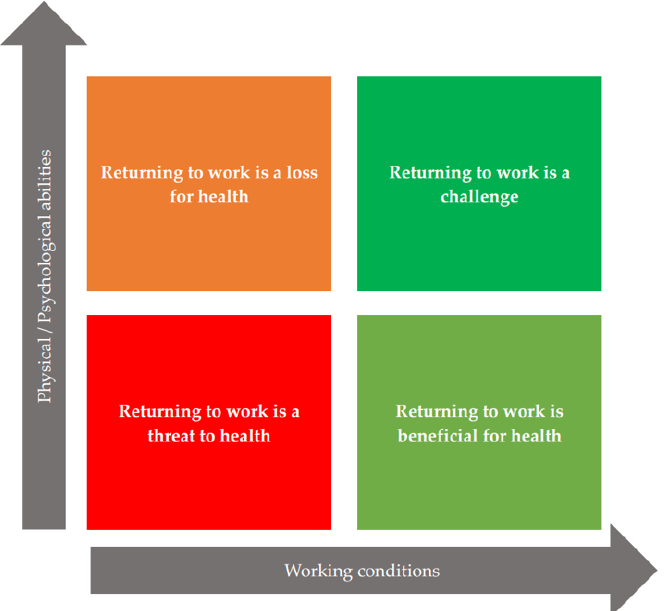
Figure 1. Profiles of patients according to physical/psychological abilities and working conditions.